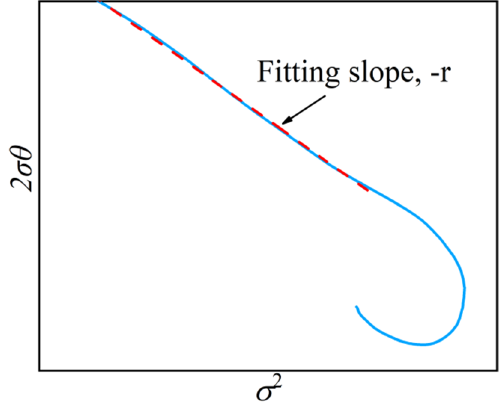
Figure 20. Fitting slope of 2 σθ ~ 2 σ curve. Table 5. Values of r under temperatures of 1123–1483 K and strain rates of 0.01–10 s − 1 .